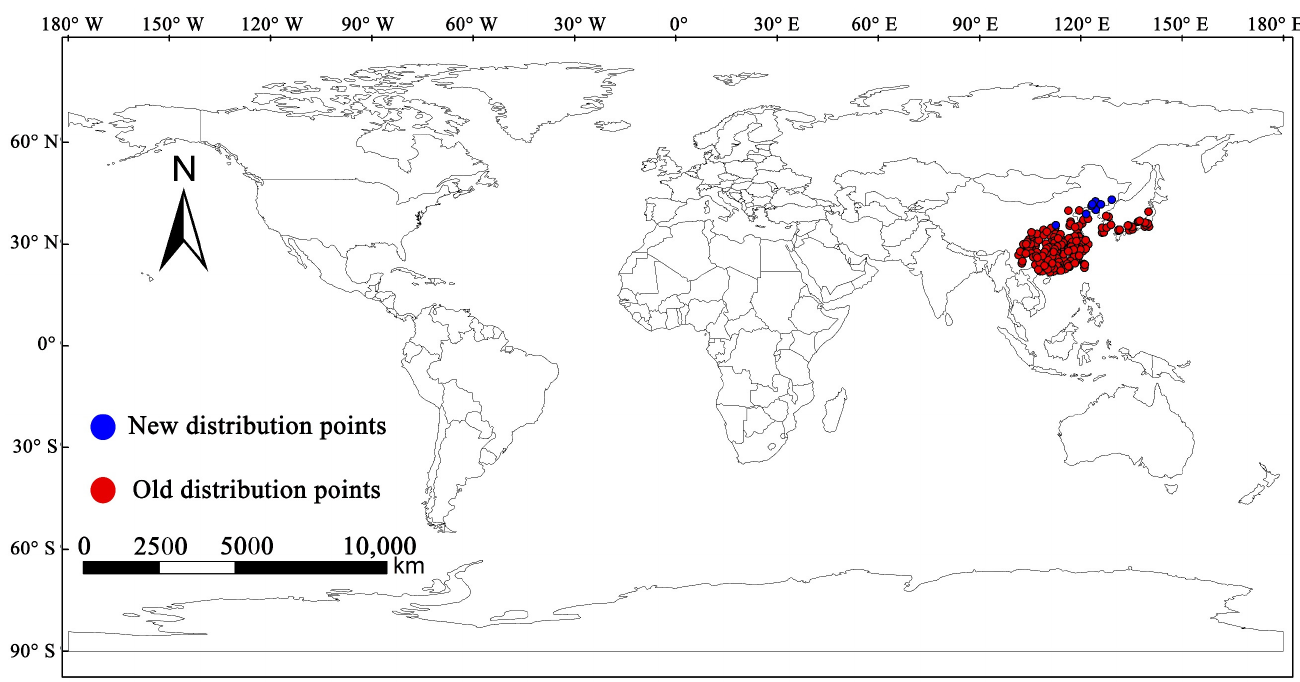
Figure 1. Geographical distribution sampling point of M. alternatus at global scale. Red dots represent the traditional distribution points and blue dots represent the new distribution points.